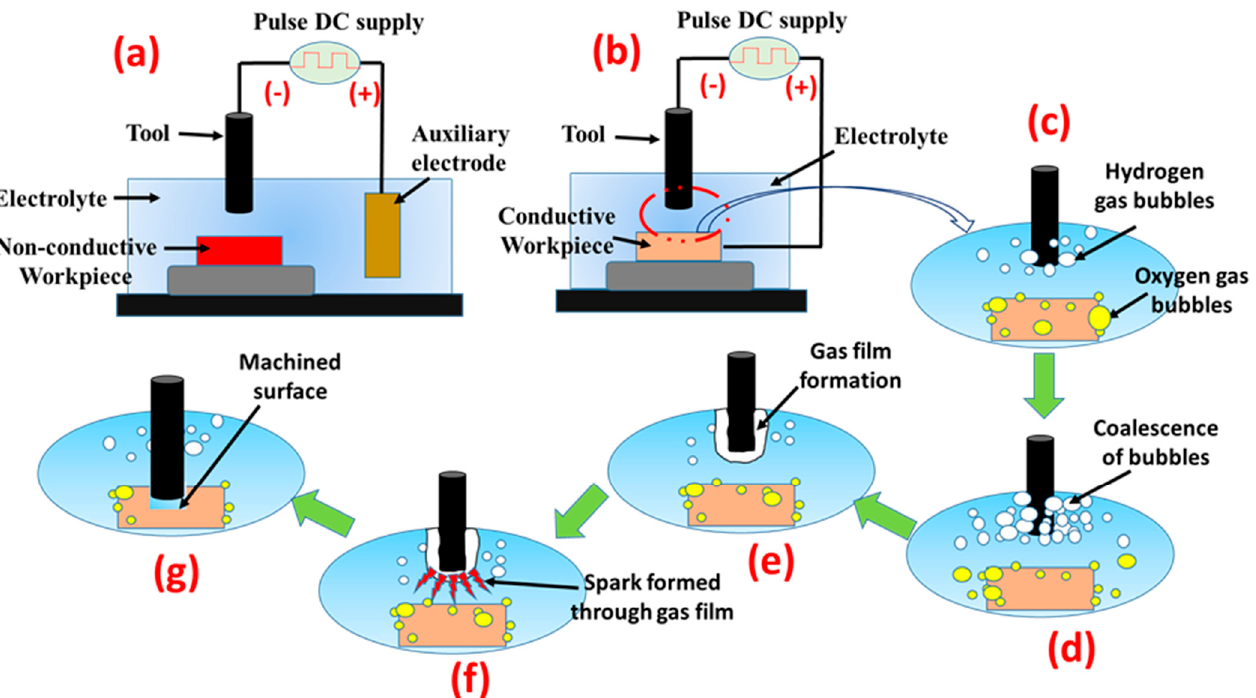
Figure 1. Working principle of µECDM for conductive and non-conductive materials [7]. ( a ) non- conductive material ( b ) conductive material ( c – f ) electrolysis process and spark generation ( g ) ma- chined hole.